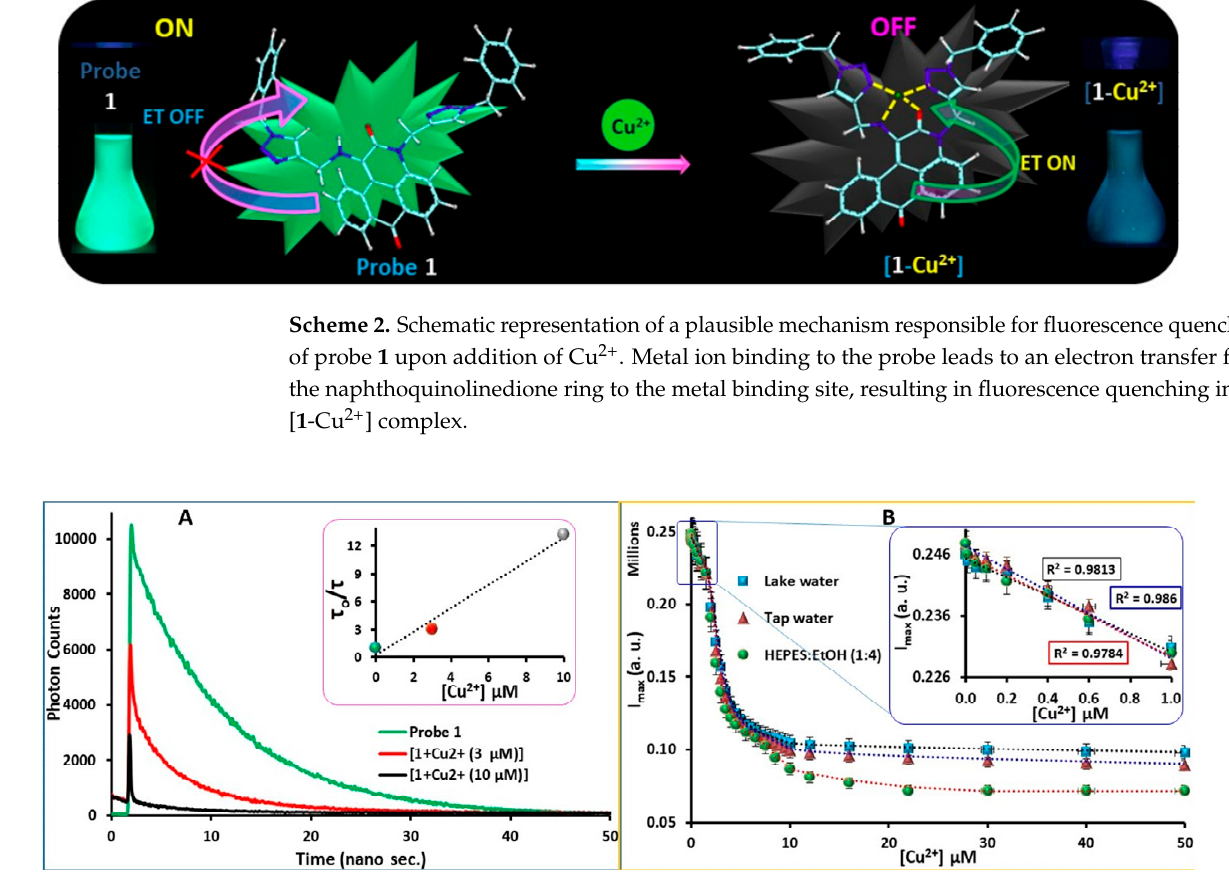
Figure 5. ( A ) Fluorescence decay profiles of probe 1 (10 µM) with increasing concentration of Cu 2+ from 0 to 0.3 (3 µM) to 1.0 equivalent (10 µM). The probe was dissolved in a solvent system (HEPES (pH = 7.4): EtOH = 4:1). ( B ) Plot of the fluorescence intensity of probe 1 (10 µ M) as a function of [Cu 2+ ] in three different media (HEPES, tap, and lake waters). The data were obtained from titration of the probe with Cu 2+ and fluorescence intensity measured at 524 nm ( I 524 ). The inset in (A) shows changes in the ratio of excited state life-time ( τ o / τ ), where τ o and τ represent excited state life-times of the probe in the absence and presence of Cu 2+ , respectively. The inset in (B) shows a linear relationship between I 524 and [Cu 2+ ] in a range of low metal ion concentration. The points and curves are the experimental values and curve fits, respectively.